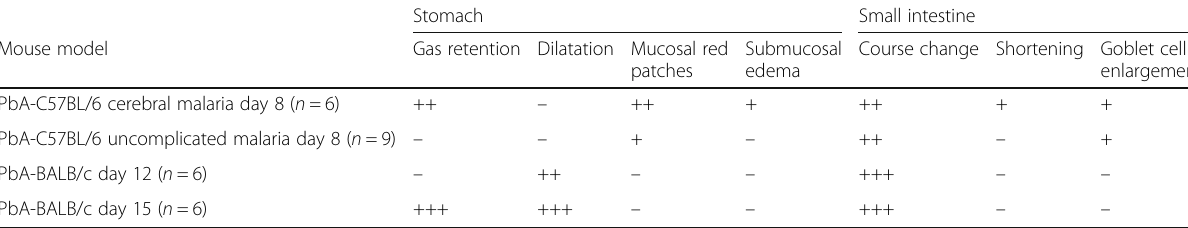
Stomach Small intestine